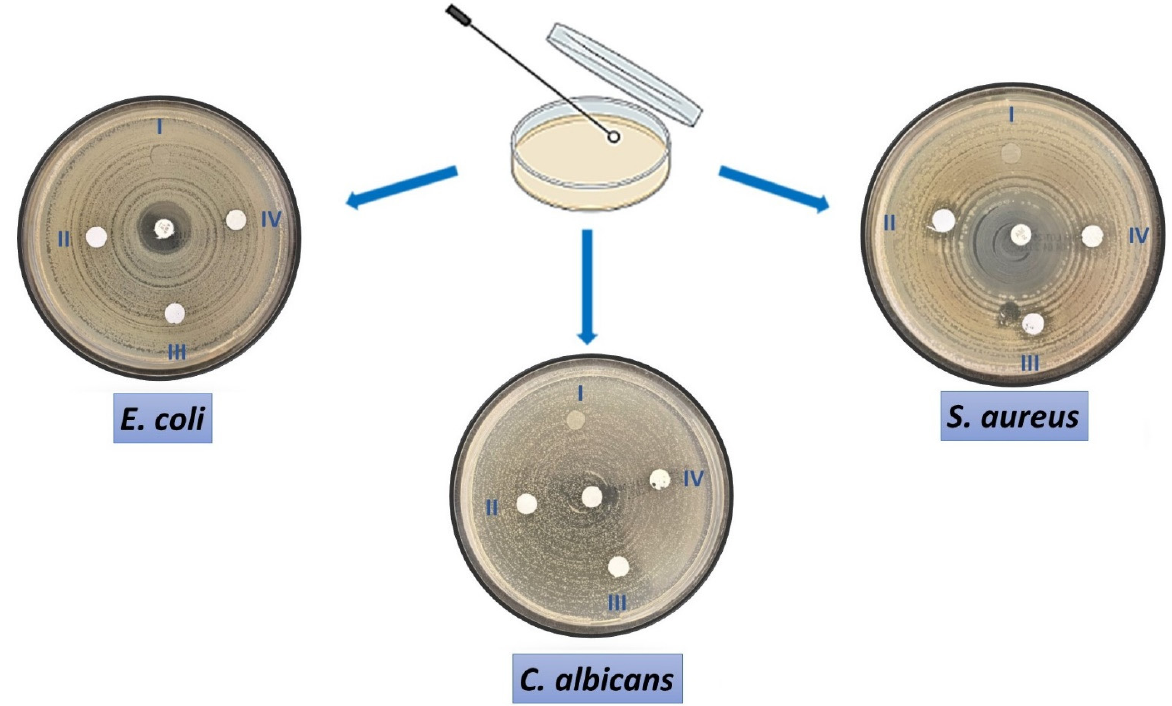
Figure 6. Antimicrobial activity of four different concentrations of PVA/ZnO fibers in E. coli, S.aureus, and C.albicans by disk diffusion method.